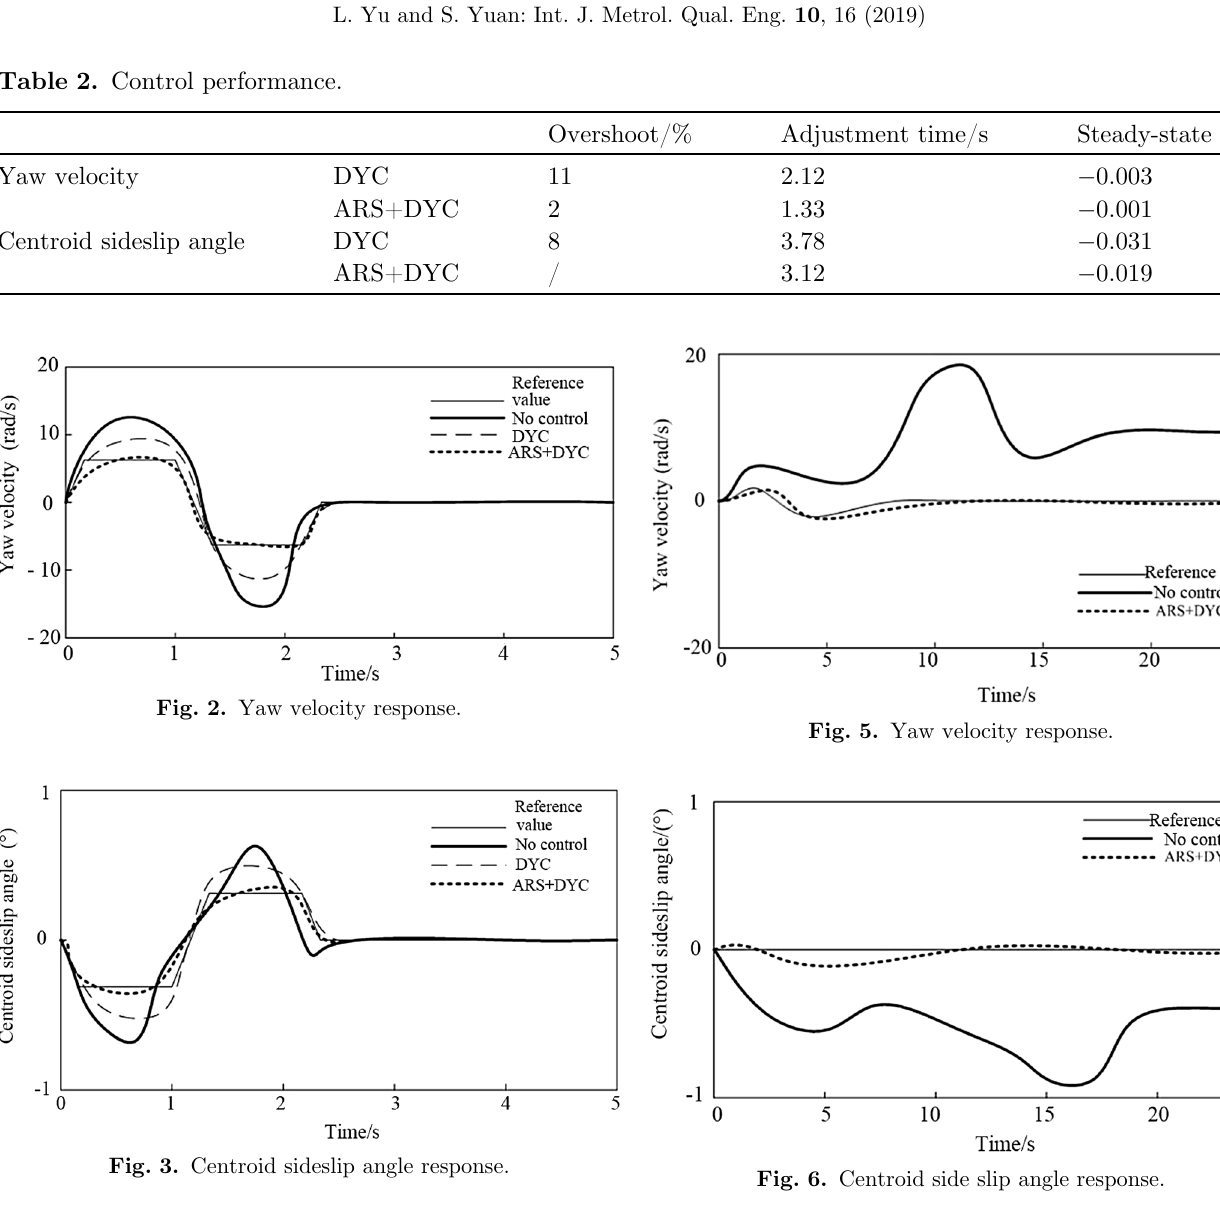
Fig. 6. Centroid side slip angle